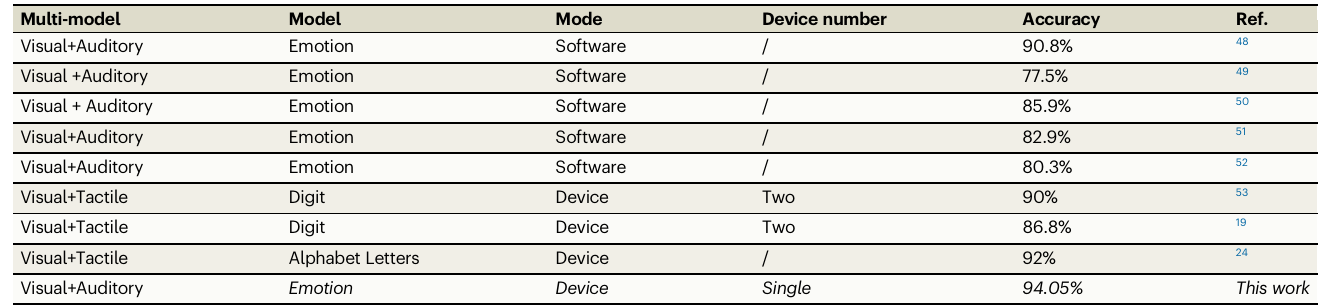
Table 1 | Accuracy of multi-modal recognition with different model Multi-model Model Mode Device number Accuracy